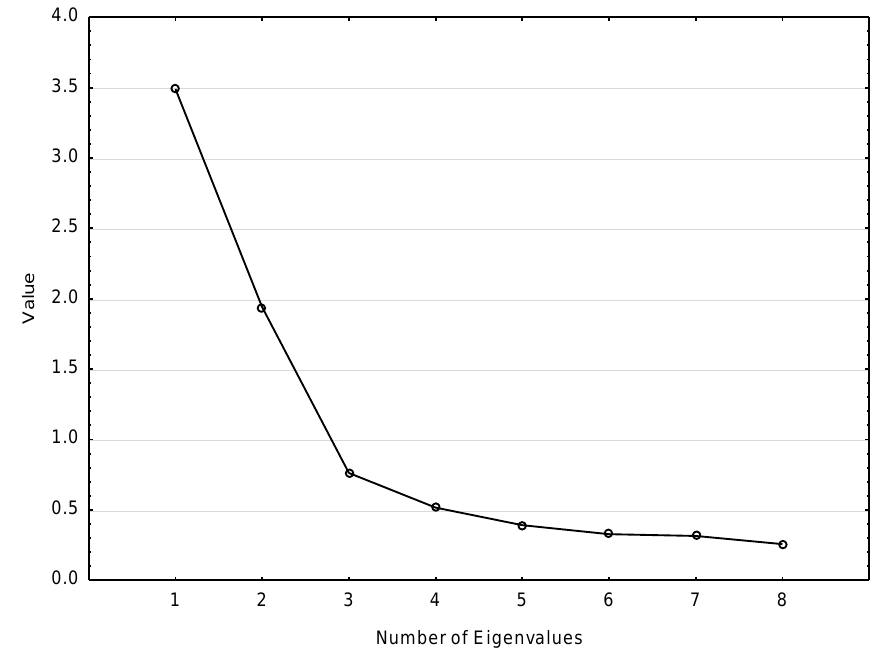
Figure 2. Plot of eigenvalues for joint items sets assessing PwD types.